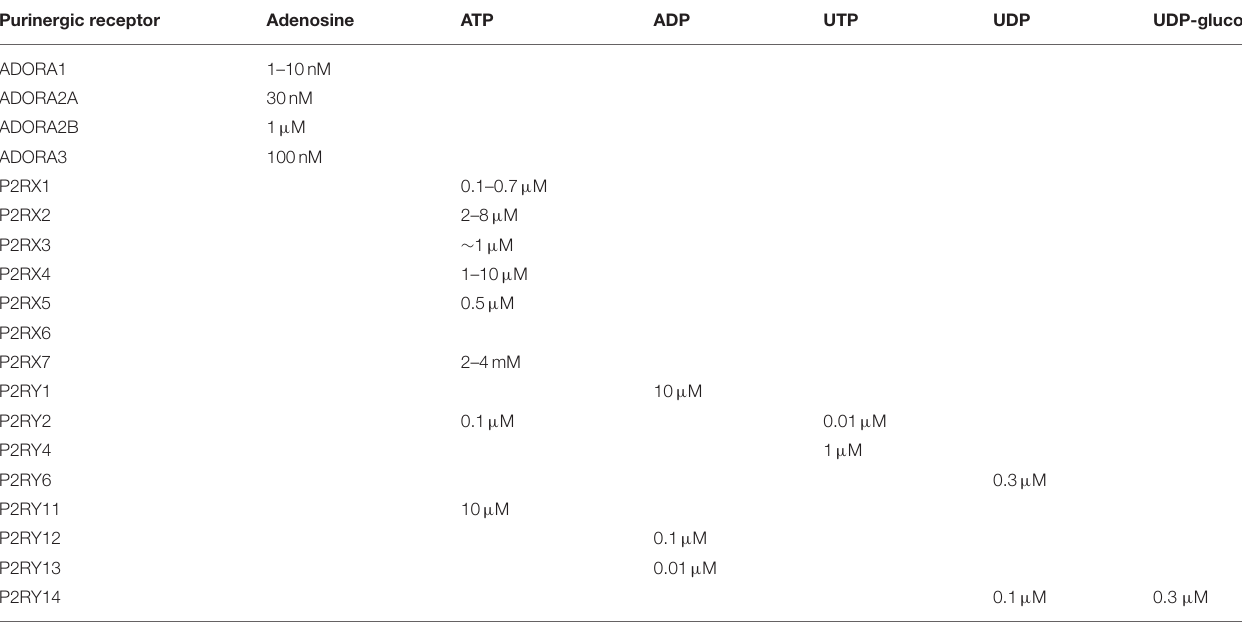
TABLE 1 | Purinergic receptor agonists and potency data. Purinergic